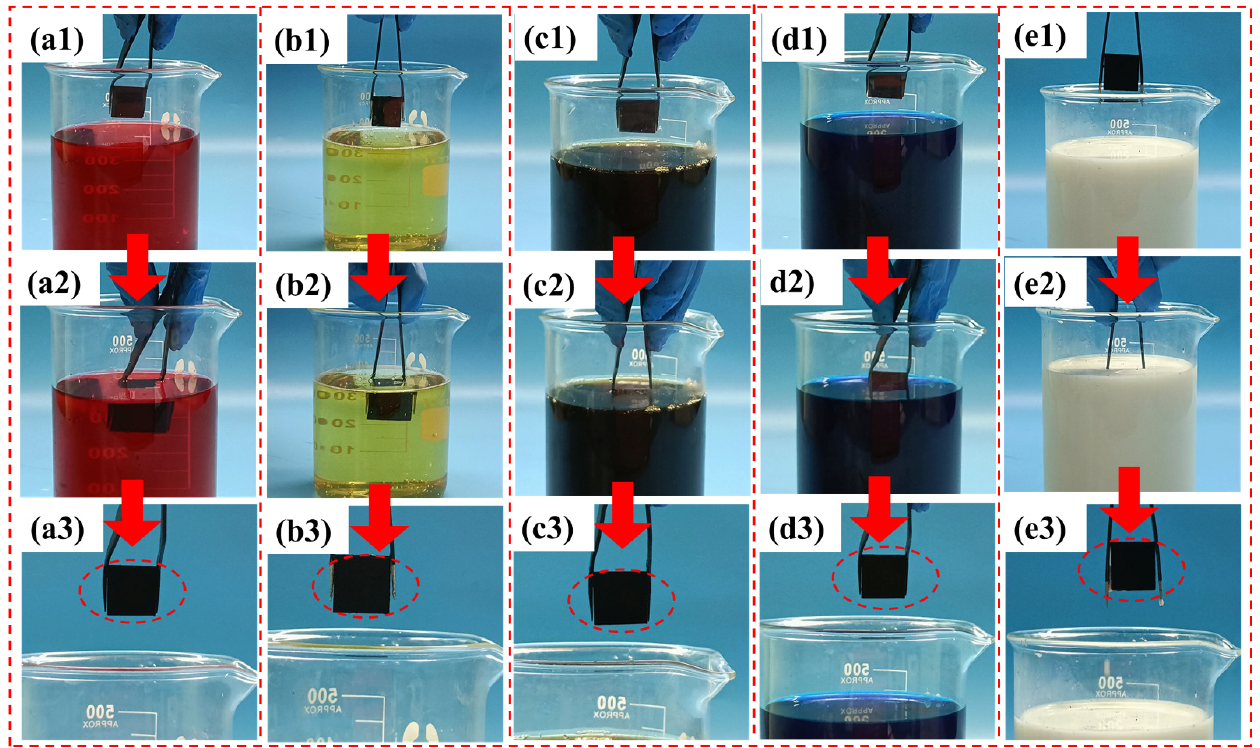
Figure 7. Self-cleaning tests of superhydrophobic coatings against common liquid contaminants in life: ( a1 – a3 ) test procedure in grape juice; ( b1 – b3 ) test procedure in beer; ( c1 – c3 ) test procedure